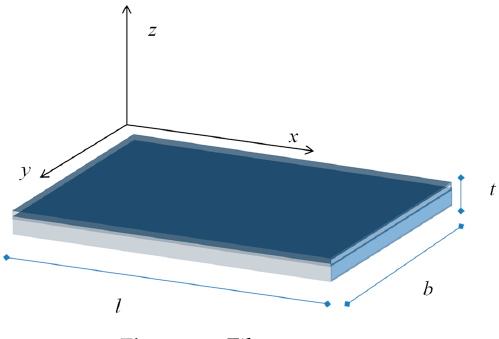
Figure 14. Film Figure 14. Film geometry.